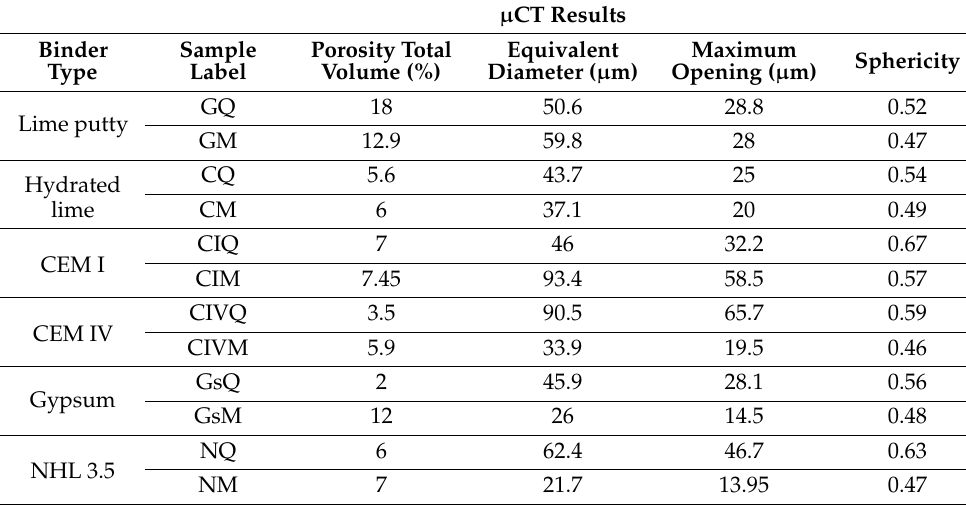
Table 3. Results of the microcomputed tomography analyses (Note that “M” is the abbreviation for crushed limestone aggregate while “Q” is the abbreviation for quartz